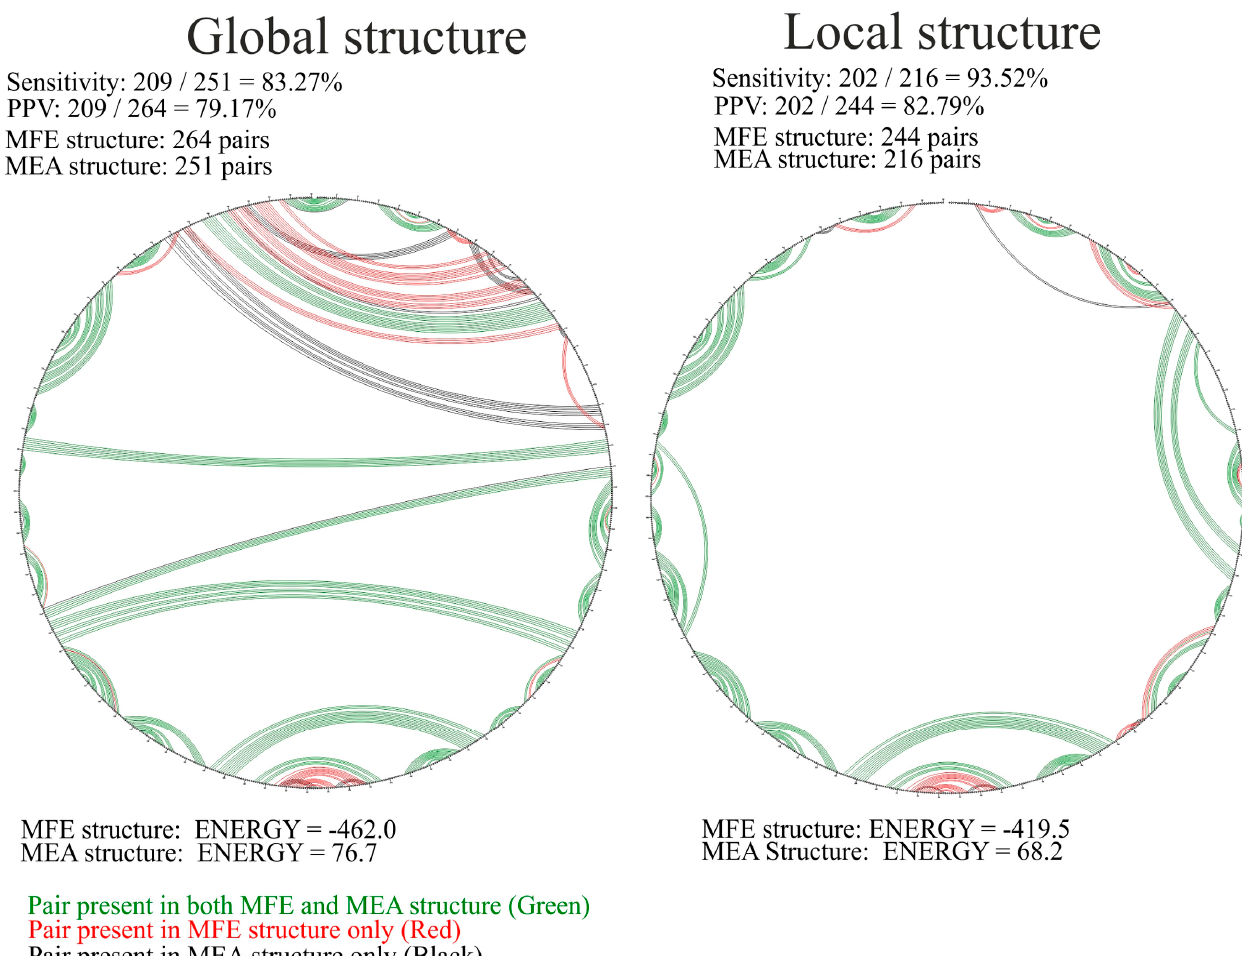
Figure 4 . Comparison of the predicted MFE and MEA structures of vRNA8 in cell lysates. For the comparison both global as well as local structures were compared via CircleCompare tool (RNAstructure www.rna.urmc.rochester.edu, accessed 27 January 2022).